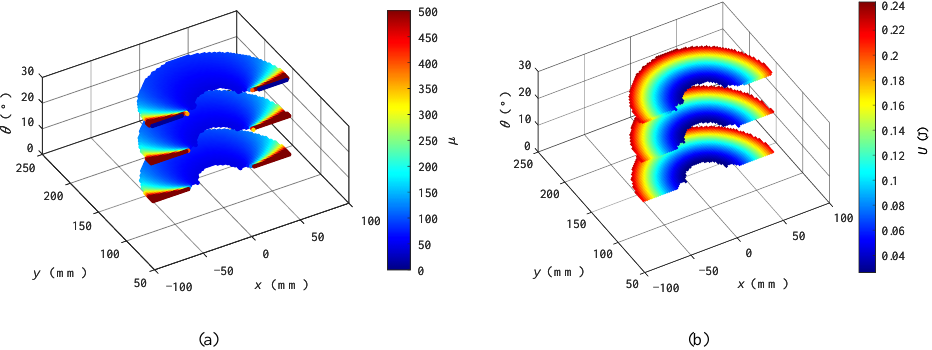
Figure 11. Manipulability and potential energy of optimized configuration (Example 1). ( a ) Manipu- lability, ( b ) potential